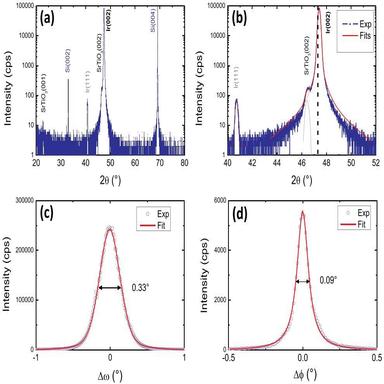
XRD characterization of Ir/STO/Si (001) heterostructure: (a) large θ/2θ scan, (b) θ/2θ scan focused on the (111)Ir and (002)Ir reflections (vertical black dashed line indicates the position of the bulk Ir (002) reflection), (c) ω-scan around the (002)Ir reflection, (d) ϕ-scan around the (200)Ir reflection at the surface region in grazing incidence configuration (GIXRD).